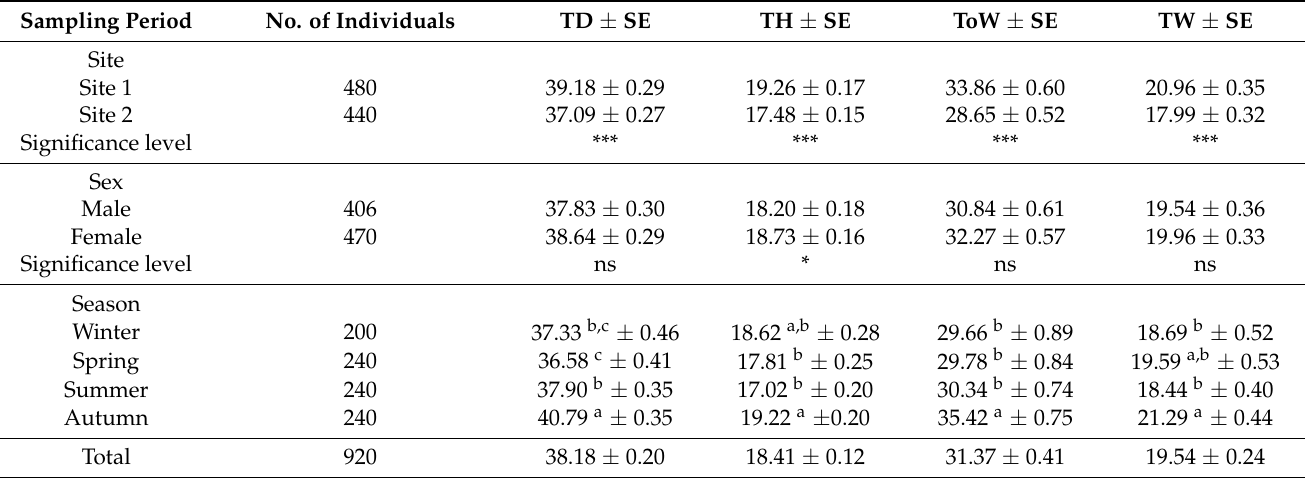
Table 2. Spatial and temporal variations in the biometric characteristics, number (n), test diameter (TD), test height (TH), total weight (ToW) and test weight (TW), represented as mean value ± standard error (SE), significance level (ns: non-significant, *: p < 0.05, ***: p < 0.001). One-way ANOVA results (F, P ) and Games–Howell pairwise comparisons of Arbacia lixula populations in the Pagasitikos Gulf